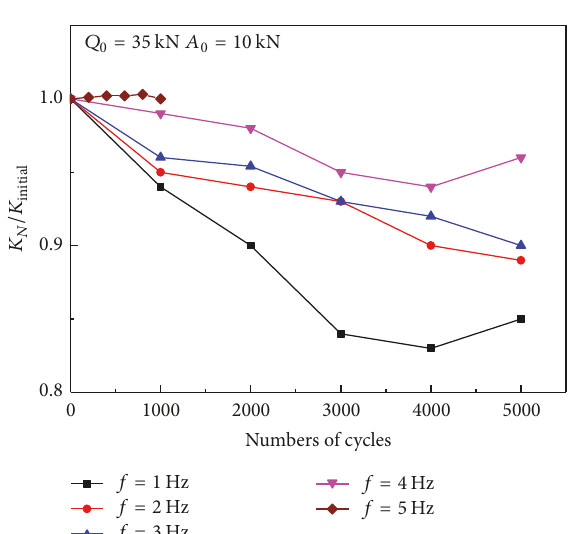
Figure 12: Variations of the secant stiffness at X-section pile head with variable loading frequencies.